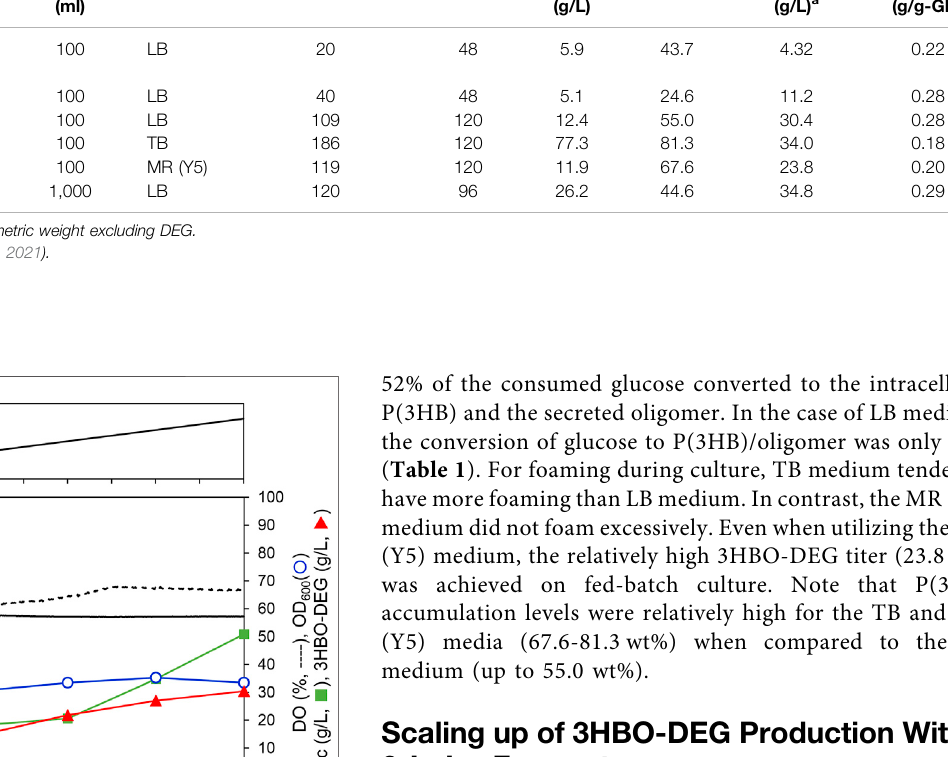
TABLE 1 | Secretory production of 3HBO-DEG via E. coli BW25113 Δ adhE harboring pGEM- phaRC YB4 AB . Operation mode